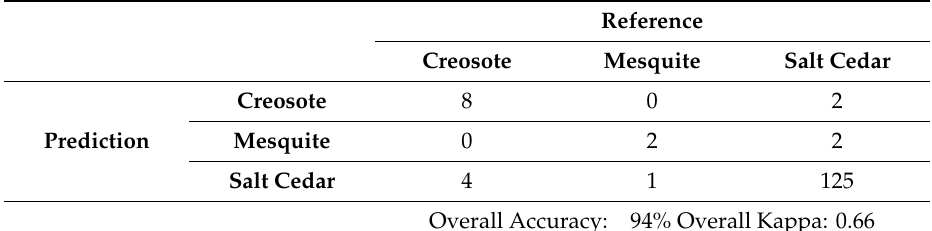
Table 2. Error matrix for 2016 classification. The classification output achieved an overall accuracy of 94 percent. Confusion occurred among the various classes mainly attributed to the size of